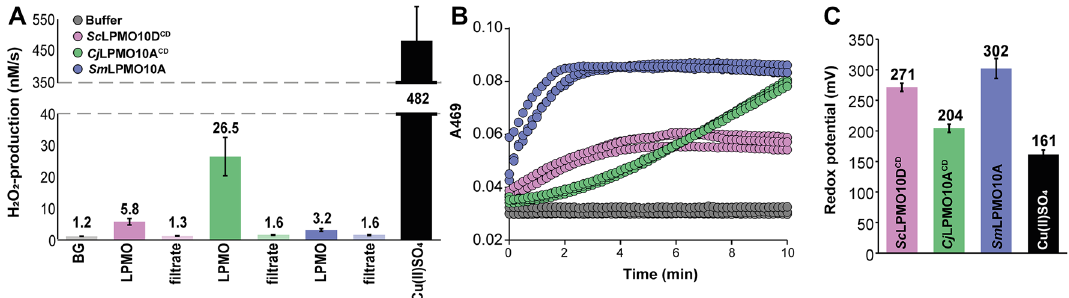
Figure 7. Apparent H 2 O 2 -production, -consumption, and redox potential. ( A ) Shows apparent H 2 O 2 production by 2 µM Sc LPMO10D CD , Cj LPMO10A CD or Sm LPMO10A in 50 mM sodium phosphate buffer, pH 6.0, supplied with 1 mM ascorbic acid, 5 U/ml HRP, 100 µM Amplex Red, and 1% (v/v) DMSO. Excess copper control reactions (labelled “filtrate”) were set up using protein-free samples, obtained by ultrafiltration of the protein preparations. These samples contained the same amount of free copper as the LPMO preparation used in the experiment. There are two additional control reactions: “BG”, for background, representing a reaction without enzyme, and “Cu(II)SO 4 ”, a reaction in which enzyme is replaced by 2 µM CuSO 4 . ( B ) Shows the apparent peroxidase activity of the three LPMOs measured by the method described by Breslmayr et al. 54 . The reactions contained 1 µM LPMO, 1 mM 2,6-DMP, and 100 µM H 2 O 2 in 20 mM PIPES buffer, pH 6.0. The panel shows traces for two independent reactions per enzyme. ( C ) Shows the obtained redox potentials for the LPMO-Cu 2+ /LPMO-Cu + couples, determined by monitoring a reaction between 150 µM reduced N,N,N ′ ,N ′ - tetramethyl-1,4-phenylenediamine (TMP red ) and 35 µM (oxidized) LPMO-Cu 2+ under anaerobic conditions. As a control, the redox potential of copper was acquired through the same method. The error bars show ± S.D. (n =